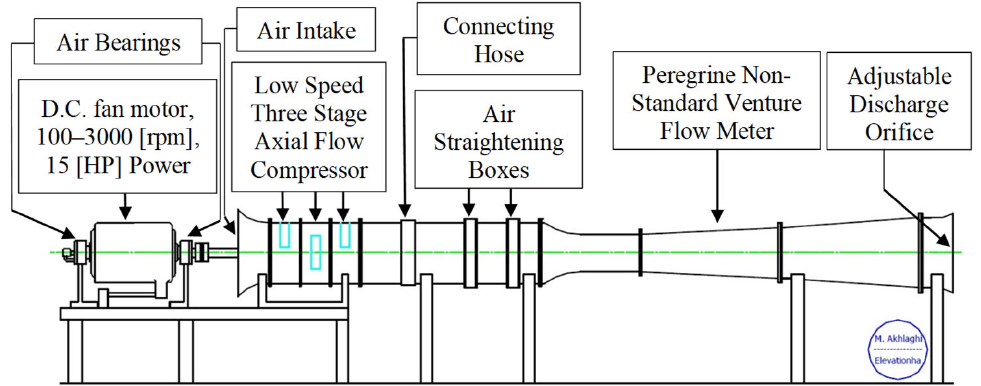
Figure 5. Layout of the test rig [25,26]. Table 12. Specification of the experimental Peregrine